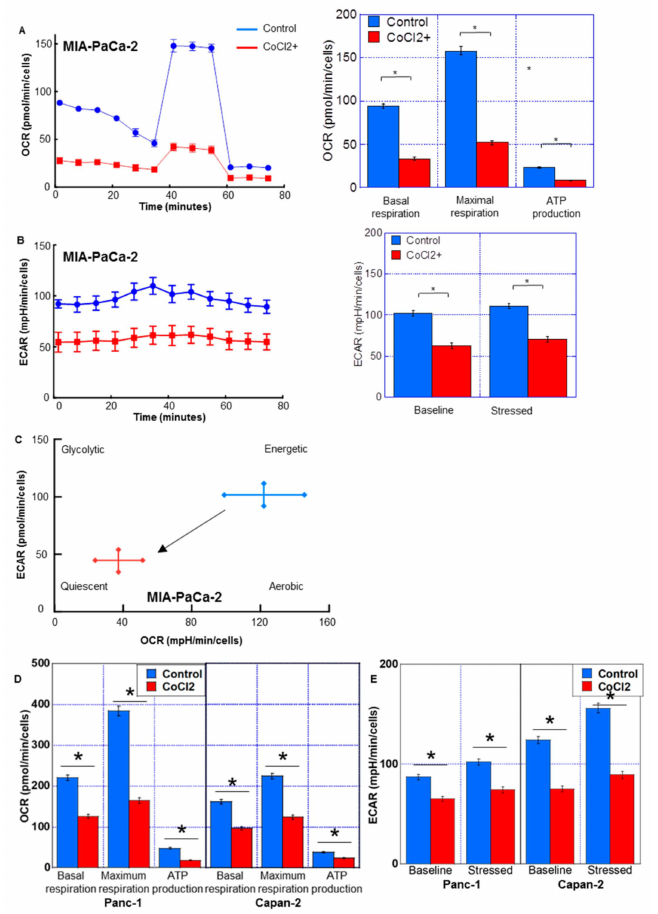
Figure 3. Energy metabolism in MIA-PaCa-2 PDA cells treated with CoCl 2 . Flux analysis of CoCl 2 (150 µ M, 72 h)-treated PDC cells. ( A , D ) Effect of CoCl 2 on the OCR, basal respiration, maximum respiration, and ATP production. ( B , E ) The effect of CoCl 2 on glycolytic activity (ECAR), baseline ECAR, and stressed ECAR (right). ( C ) Effect of CoCl 2 on the cell energy phenotype profile. Error bars indicate standard error from three trials. * p < 0.05. Statistical significance was calculated using ordinary analysis of variance. PDA, pancreatic ductal adenocarcinoma; OCR, oxygen consumption rate; ECAR, extracellular acidification